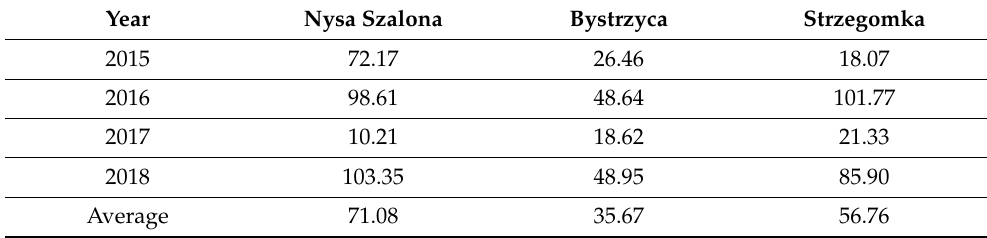
Table 5. Metal pollution index (MPI) of aquatic plants, bottom sediments, and water with aluminum [24,25].